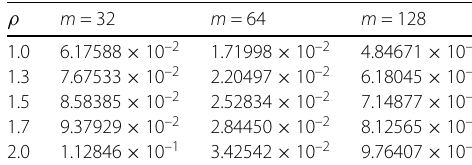
Table 2 Maximum absolute difference for distinct values of ρ , m , and α = 0.75